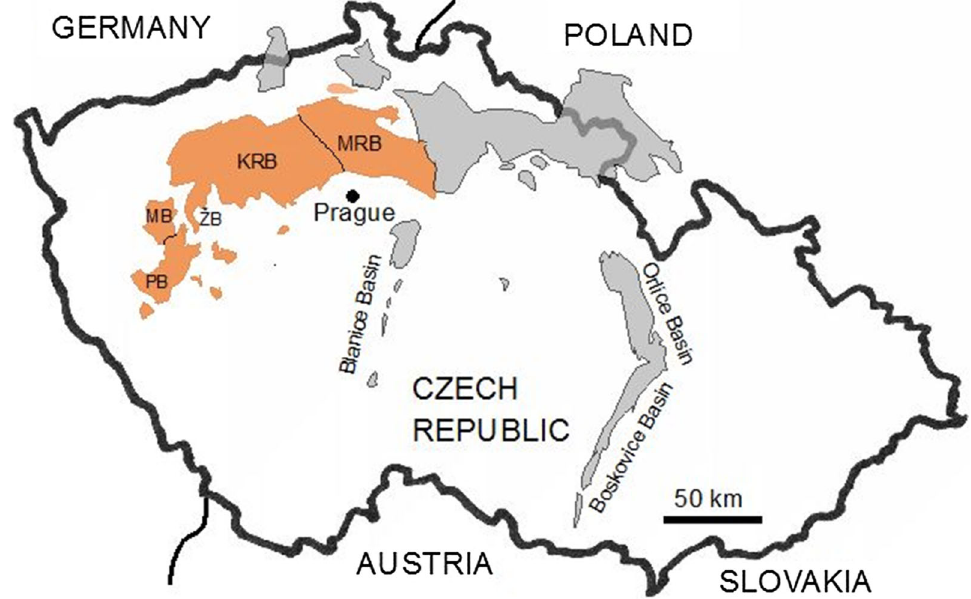
Fig. 1 Late Paleozoic continental basins of the Czech Republic. KRB Kladno–Rakovnı´k. Basin, MRB Msˇeno–Roudnice Basin, ZˇB Zˇihle Basin, MB Maneˇtı´n Basin, PB Pilsen Basin (marked in orange: the Central and Western Bohemian Basins; marked in grey: Sudetic Basins: Lusatian and Intra-Sudetic